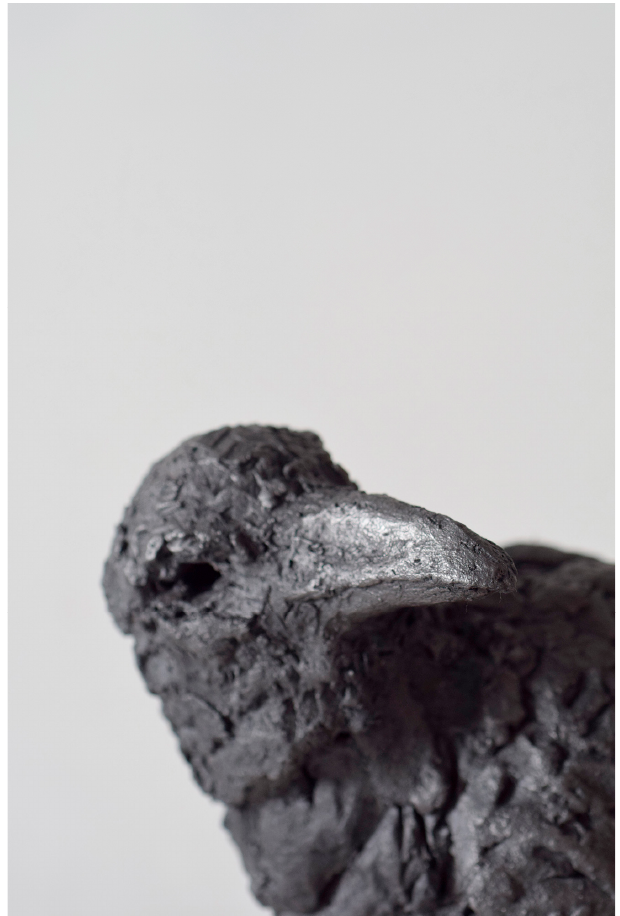
Figure 4. Crow (2020), Alternator Studio. Ceramic, 25 × 45 × 19 cm.